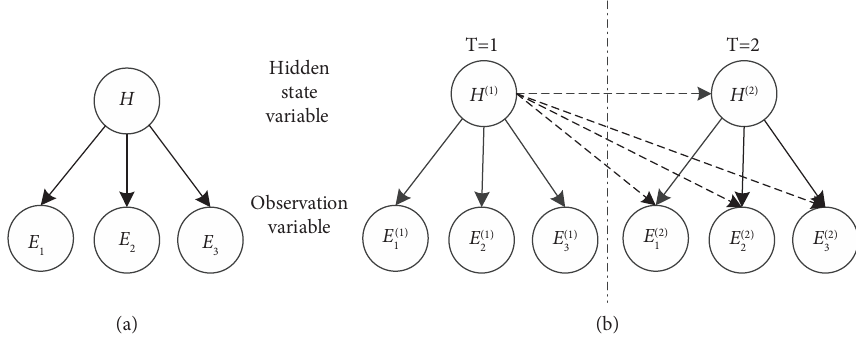
Figure 5: Structure diagram of dynamic Bayesian network model. (a) SBN. (b) the transition between the crash states of two time series, and is represented by dashed lines.